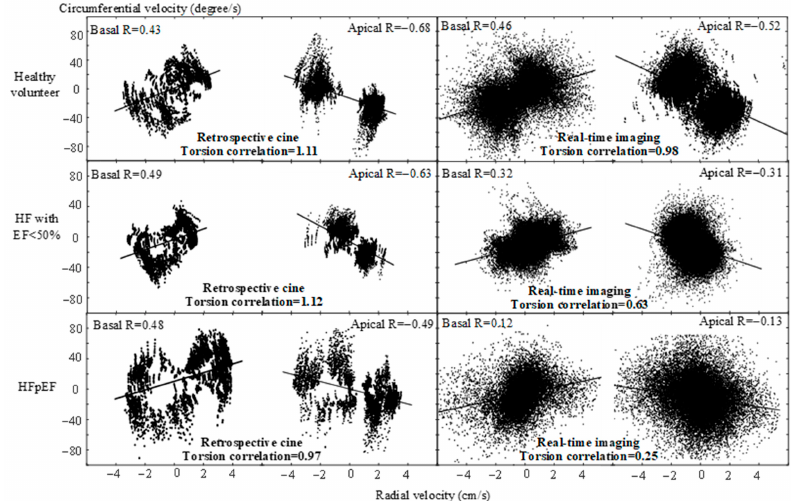
Figure 5. Examples of correlation analysis between radial and circumferential velocity measurements in retrospective cine and real-time images, respectively, from a healthy volunteer, from a HF patient with EF < 50%, and from a patient with HFpEF. The torsion correlation from real-time imaging was considerably different among three subjects while that from retrospective cine comparable. Figure 6A gives the one-way ANOVA statistics for the measurements of torsion cor- relation in the healthy volunteers, HF patients with EF < 50% and patients with HFpEF. Significant differences were found in the real-time measurements ( P ≤ 0.01), but not in the retrospective measurements ( P ≥ 0.5). Figure 6B shows the scatter plots of EF against tor- sion correlation, respectively from retrospective cine and from real-time imaging. The HF patients with EF < 50% were separated from the other two groups due to the difference of EF in both plots. The healthy volunteers and the patients with HFpEF were mixed in the plots from retrospective cine images while they were differentiated in those from real- time images.